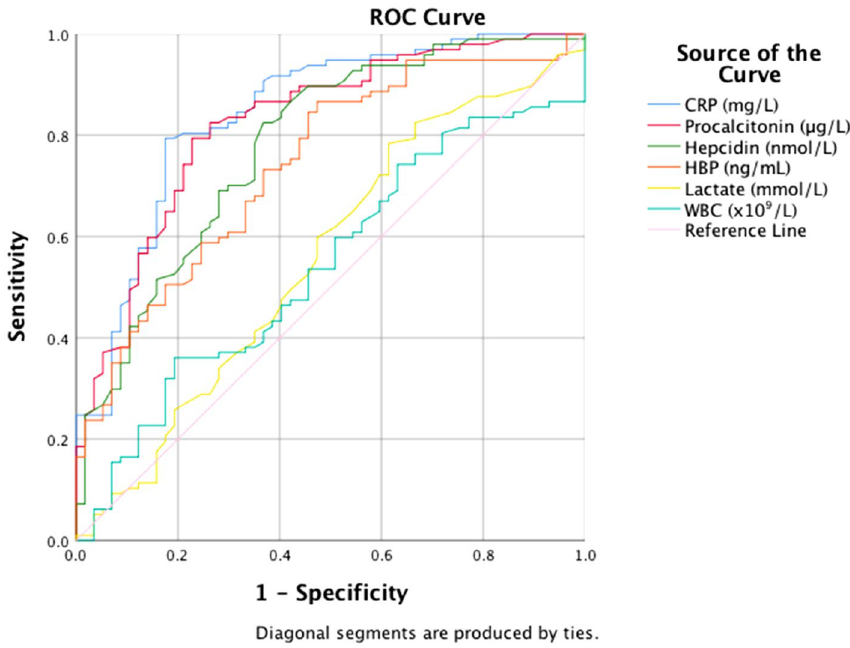
Figure 3. Receiver-operating characteristics curves of C-reactive protein (CRP), procalcitonin, hepcidin, heparin-binding protein (HBP), lactate and white blood cell (WBC) predicting sepsis/septic shock diagnosis.